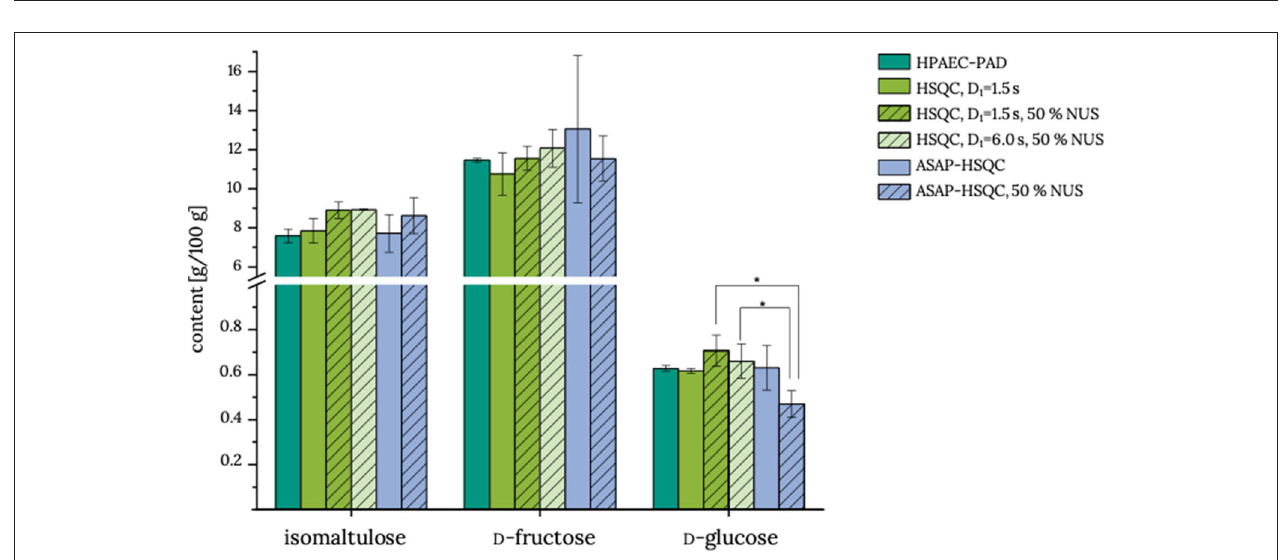
FIGURE 4 | Contents of isomaltulose, D -fructose, and D -glucose in food product 3 . HPAEC-PAD, high-performance anion-exchange chromatography with pulsed amperometric detection; HSQC:, heteronuclear single quantum coherence; D 1 , interscan delay; NUS, non-uniform sampling; ASAP, acceleration by sharing adjacent polarization. All measurements were performed in triplicate determination, and the standard deviation is given. * indicates mean values that are statistically different (one-factor analysis of variance, α = 0.05, post-hoc Tukey test). Actual data are given in Supplementary Table S3 .